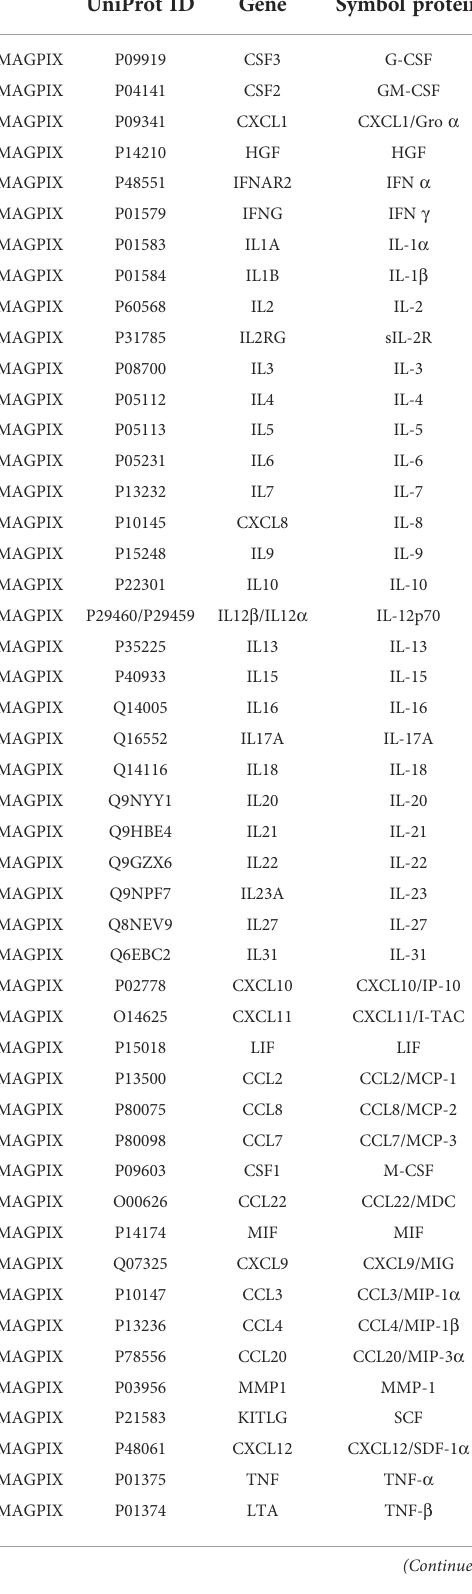
TABLE 2 List of soluble immune factors in the study.